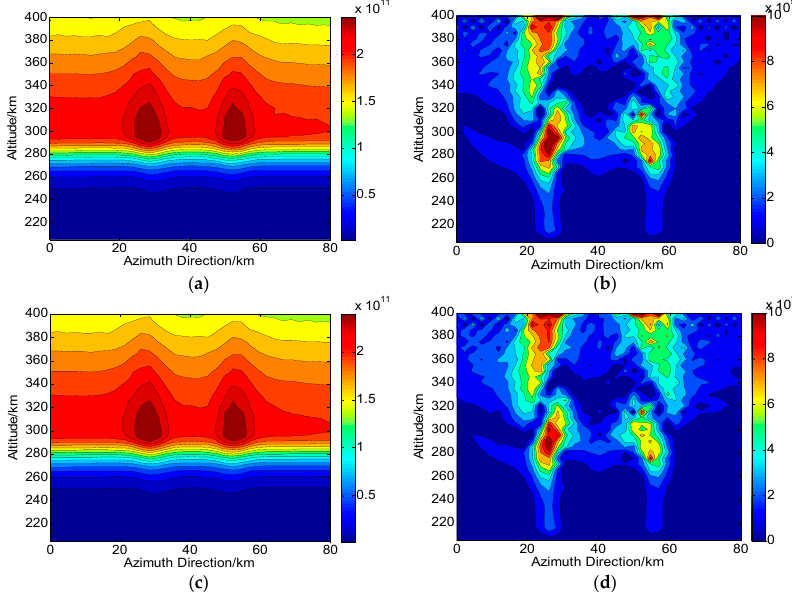
Figure 14. Two-dimensional CIT reconstructions under the condition of channel amplitude imbalance in Qingdao ( Ω C is used). ( a , c ) are the reconstructed results with 0.1 dB and 0.5 dB, respectively. ( b , d ) are the corresponding absolute deviations between the true and reconstructed results. The unit of the electron density is electrons · m − 3